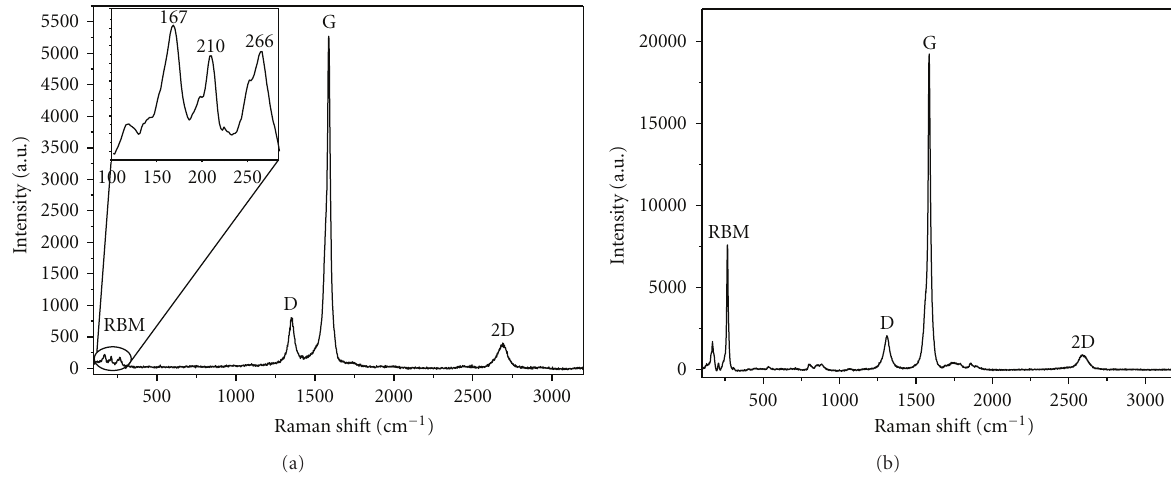
Figure 1: (a) Raman spectra of SWCNT using (a) 2.41 eVand (b) 1.58 eV laser excitation. Significant peaks are labeled. The laser power measured at the sample was 0.1 mW for (a) and 0.4 mW for